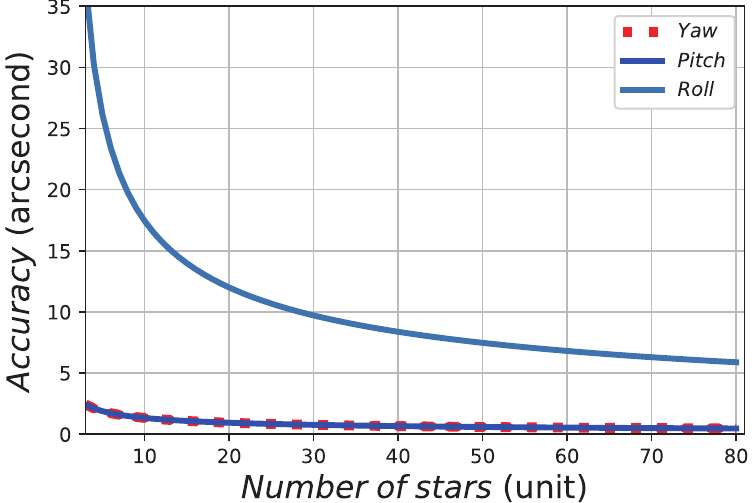
Figure 3. The relationship between the accuracy of a star sensor (SSR) and the NOS in the